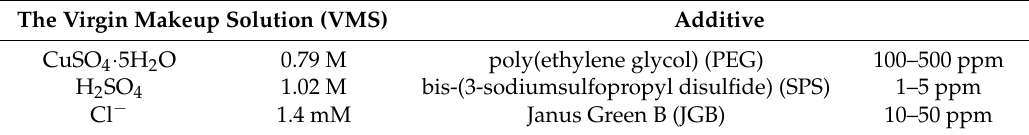
Table 1. Composition of Cu bath.